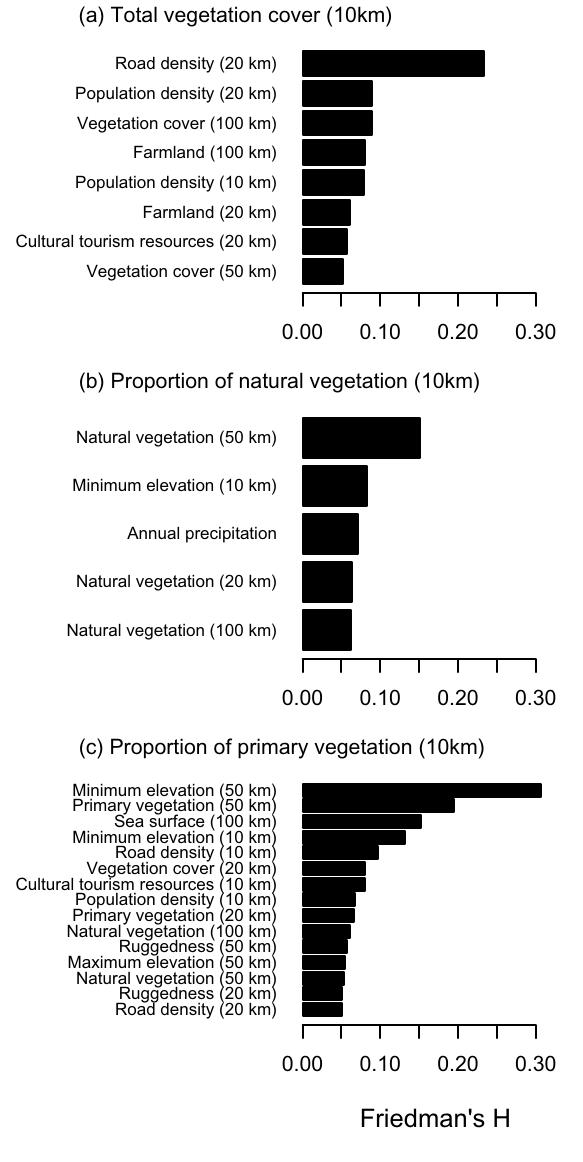
Figure 4. Relative importance of interactive effects evaluated by Friedman’s H statistic for each of the three vegetation variables. Only variables with Friedman’s H ≥ 0.05 were shown. The values in parentheses are the spatial scale (distance from the center of each grid,